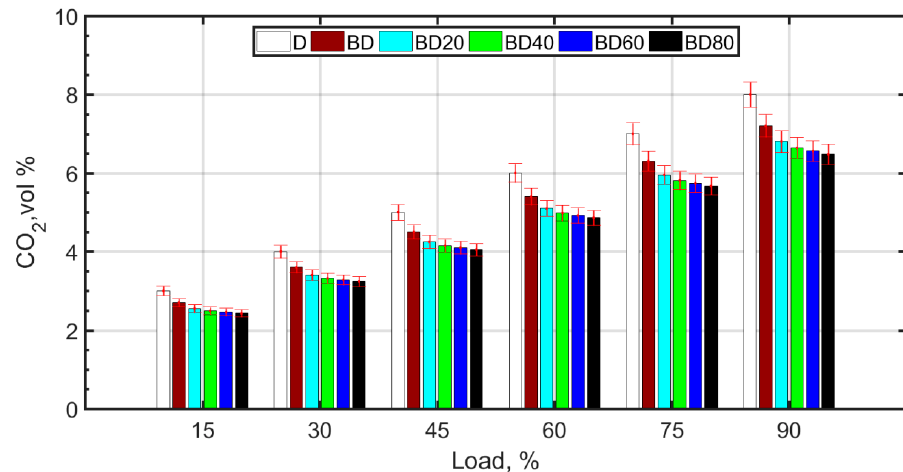
Figure 6. CO 2 variation with load.